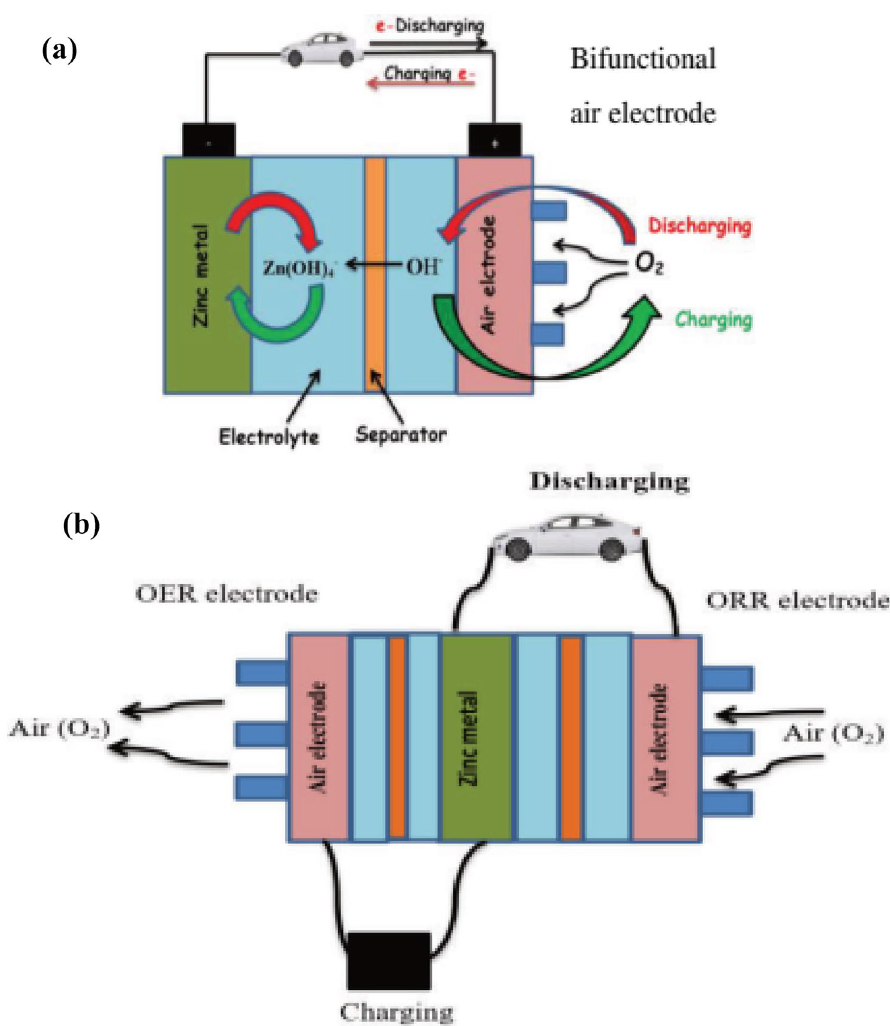
Fig. 1 Configurations of RZAB design: a two electrode and b tri-electrode (Modified from reference